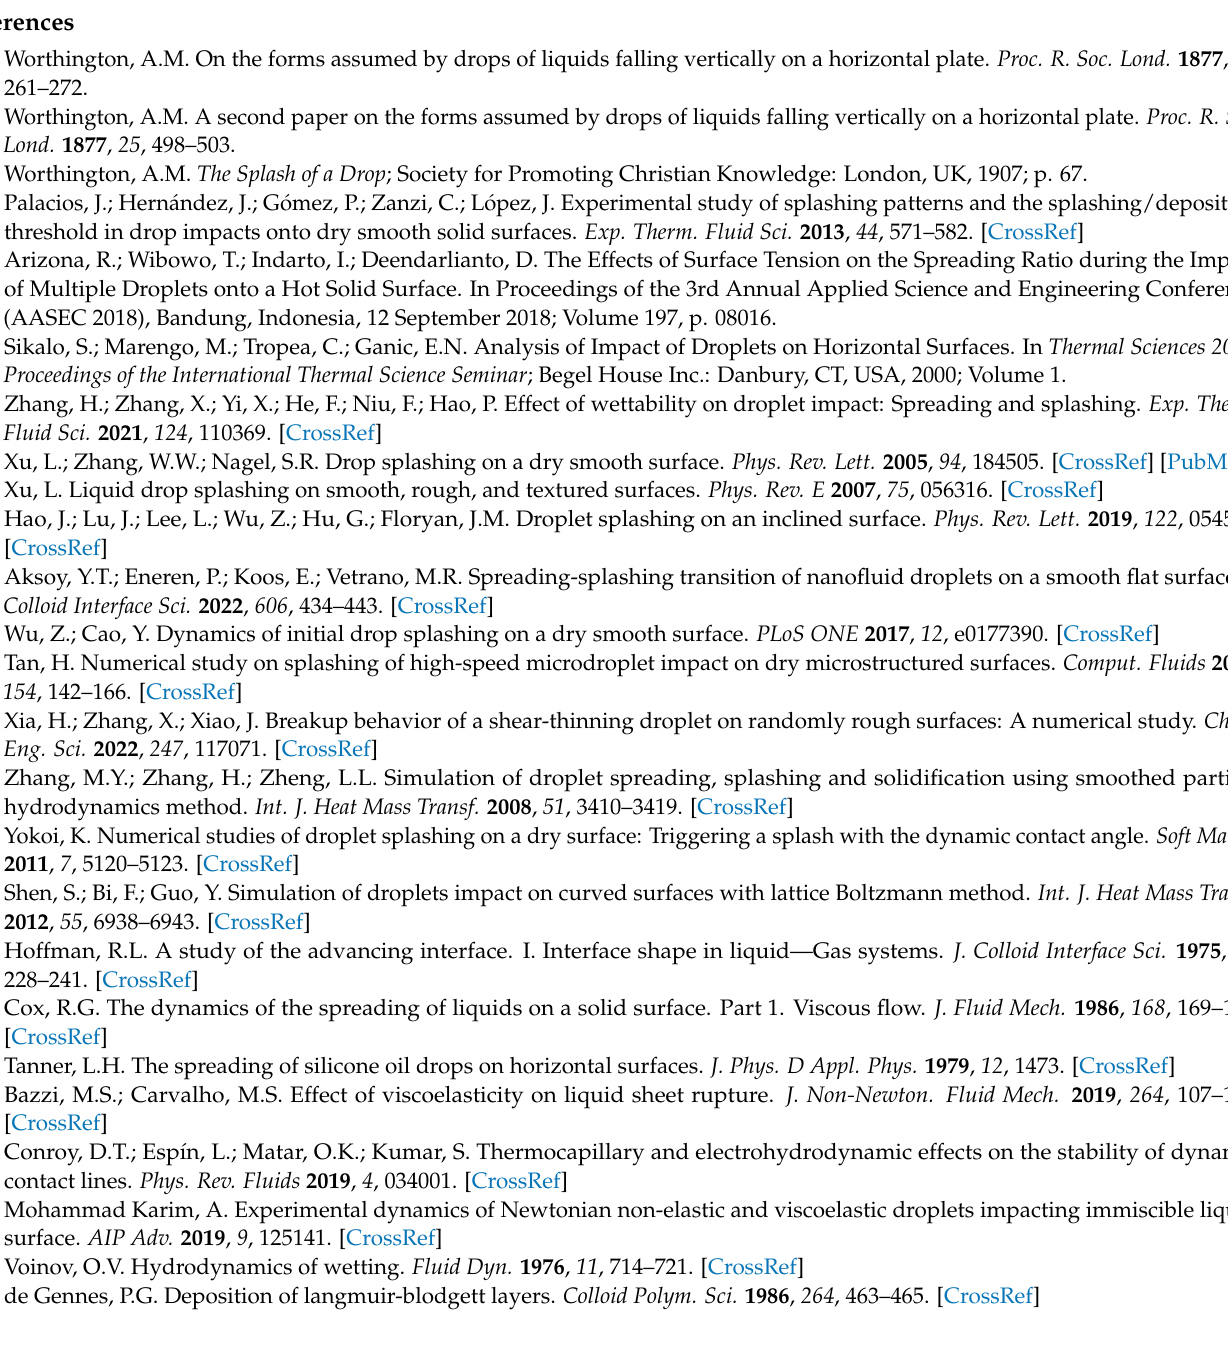
(3) Due to the difference in the wire shape, the incident angle has different effects on droplet splashing. When the droplet impacts the flat wire, the influence of incident angle on the critical splash velocity is non-monotonic, while the critical splash velocity increases with the increase in incident angle if the wire is